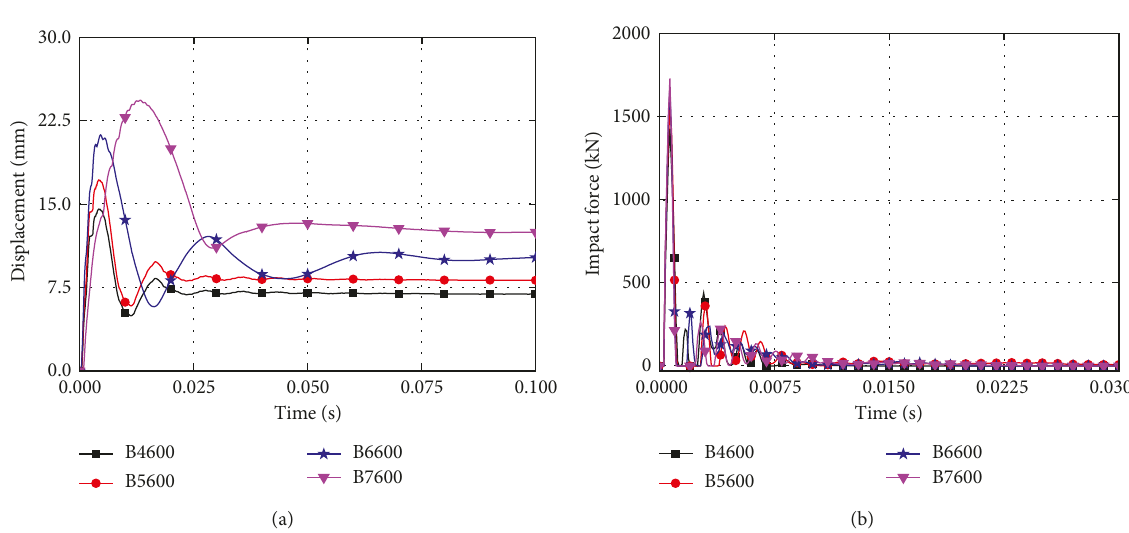
Figure 14: Comparison of impact response (constant speed and variable quality). (a) Comparison of midspan displacement. (b) Comparison of impact